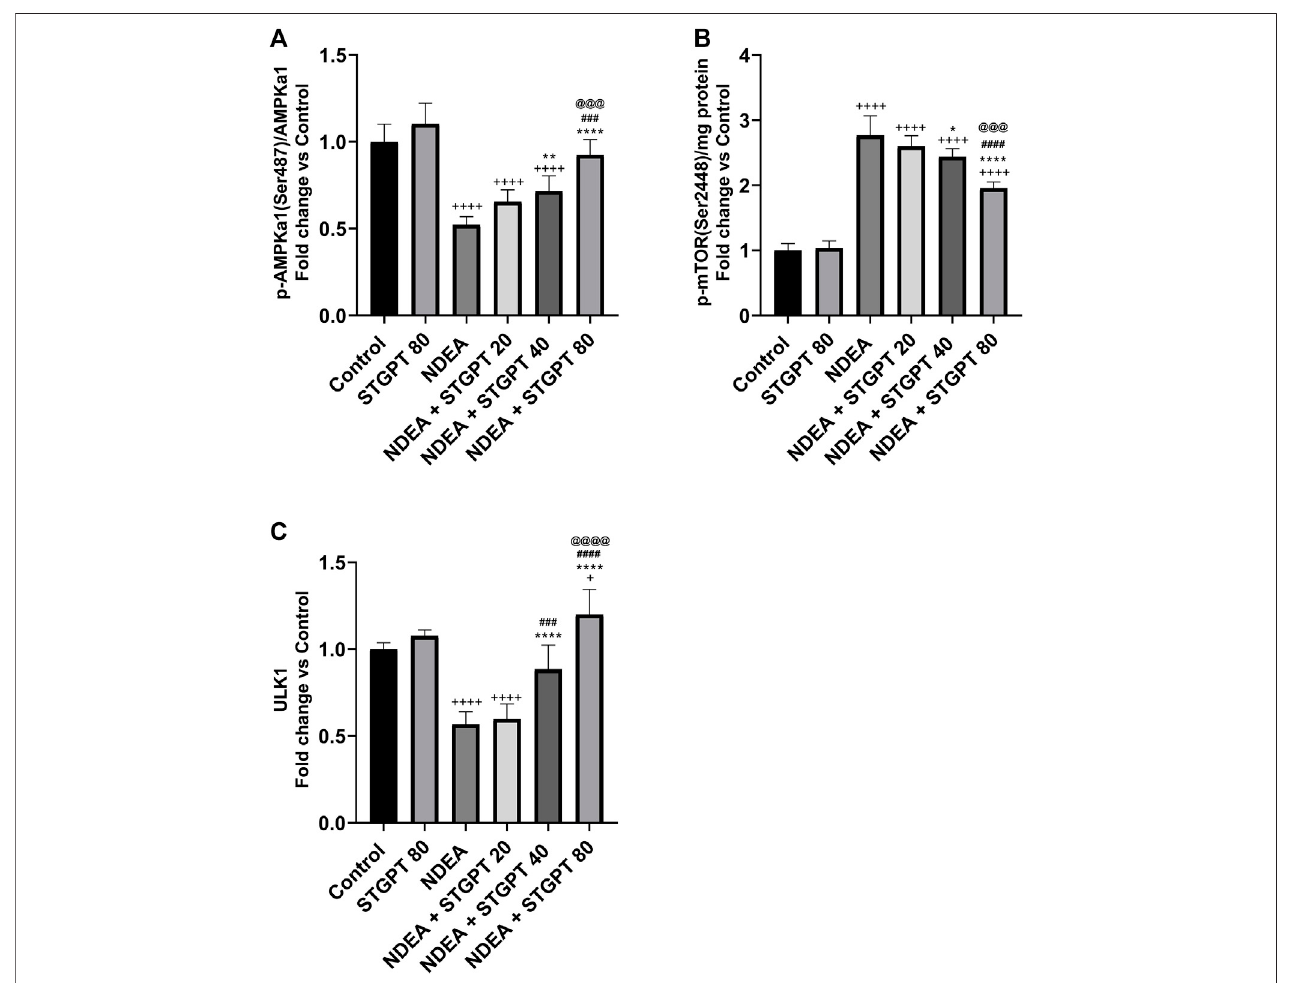
FIGURE6| EffectofSTGPT(20,40and80 mg/kg)onp-AMPK α (Ser487)/AMPK α (A) ;p-mTOR(S2448) (B) ;andULK1 (C) inmicewithNDEA-inducedHCC.Data are presented as the mean ± SD ( n (cid:1) 6). + p < 0.05 vs. Control group, ++++ p < 0.0001 vs. Control group, * p < 0.05 vs NDEA group, ** p < 0.01 vs. NDEA group, **** p < 0.0001 vs. NDEA group, ### p < 0.001 vs. STGPT 20 group, #### p < 0.0001 vs. STGPT 20 group, @@@ p < 0.001 vs. STGPT 40 group, @@@@ p < 0.0001 vs. STGPT 40 group.Control,normalcontrolgroupreceivedthevehicle;STGPT80,normalgroupreceivedsitagliptin(80 mg/kg);NDEA,NDEA-inducedHCCgroupreceivedthe vehicle; NDEA + STGPT 20, NDEA-induced HCC group treated with sitagliptin (20 mg/kg); NDEA + STGPT 40, NDEA-induced HCC group treated with sitagliptin (40 mg/kg); NDEA + STGPT 80, NDEA-induced HCC group treated with sitagliptin (80 mg/kg).